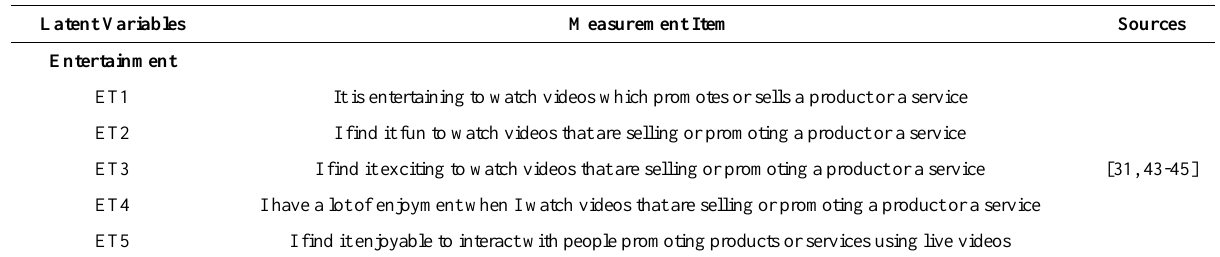
Table 1. Latent Variables and Measurement